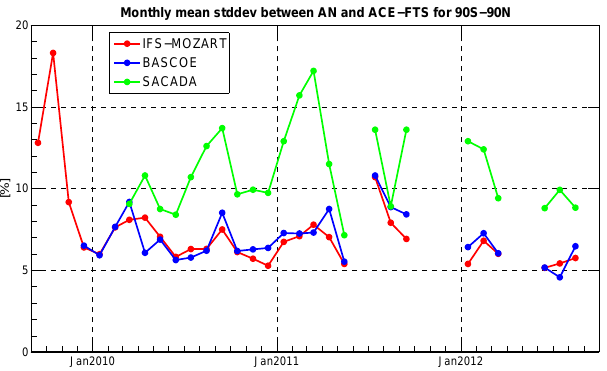
Figure 5. Comparison of the global (i.e. from 90 ◦ S to 90 ◦ N) monthly mean standard deviation between IFS-MOZART (red), BASCOE (blue), and SACADA (green) with ACE-FTS (analysis minus observations) in %, for the [200,5]hPa pressure bin, for the period September 2009 to September 2012. Standard deviations for levels with less than 20 observations are omitted. Note that standard deviations are not weighted by the cosine of the latitude.